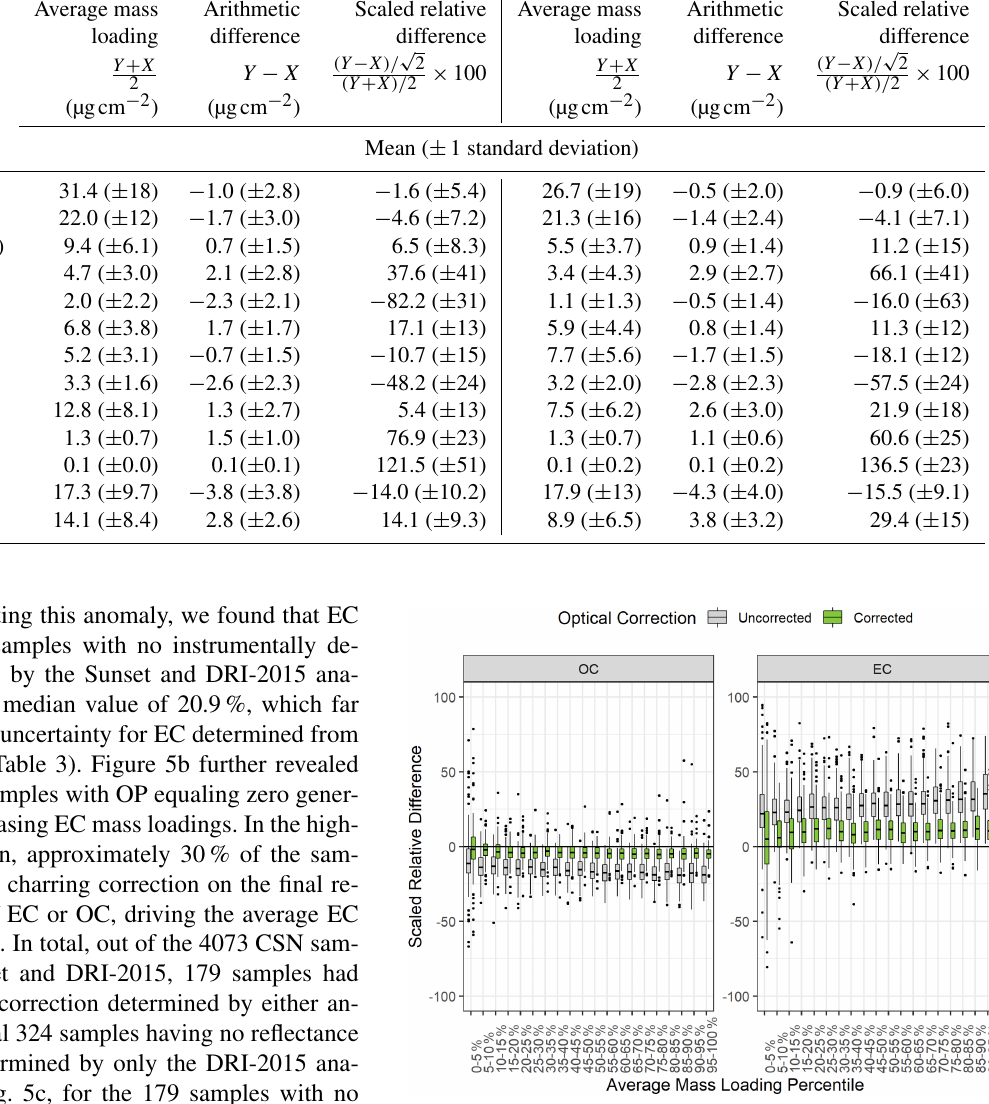
Figure 4. Distribution of scaled relative difference between Sunset and DRI model 2015 in uncorrected OC and EC (i.e., OC 1 + 2 + 3 + 4 and EC 1 + 2 + 3 , gray boxes) and corrected OC and EC (green boxes). SRDs are sorted by the average mass loading between Sunset and DRI-2015 measurements of each parameter and are plotted for each 5th percentile bin. The thick horizontal lines indicate the median, and the upper and lower limits of the boxes represent the 75th and 25th percentile, respectively. The whiskers extend to 1.5 × IQR (IQR is the interquartile range, or the distance between the 25th and the 75th percentiles). Outliers are shown as black